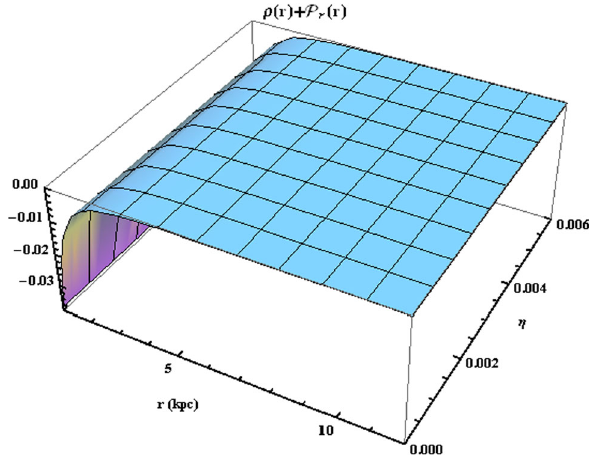
Fig. 6 ρ( r ) + P r ( r ) is plotted with respect to the radial coordinate r corresponding to the parameters ρ 0 = 0 . 004 kpc − 2 , α = 0 . 5 , β = 0 . 8 , r th = 1 kpc and r 0 = 2 kpc